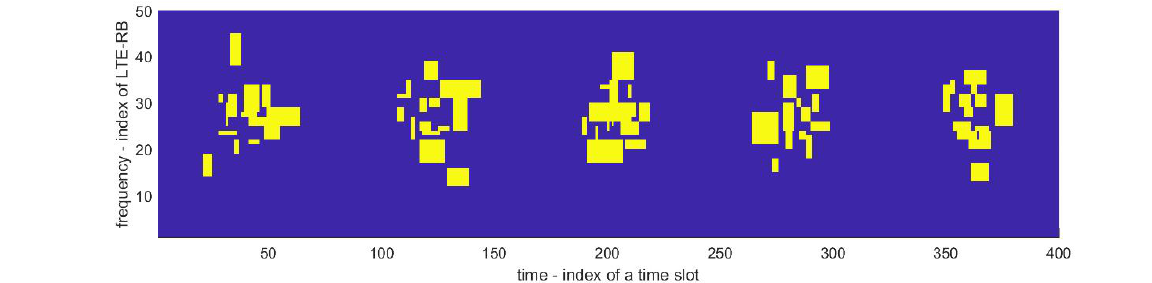
Figure 5. Transmitted LTE Resource